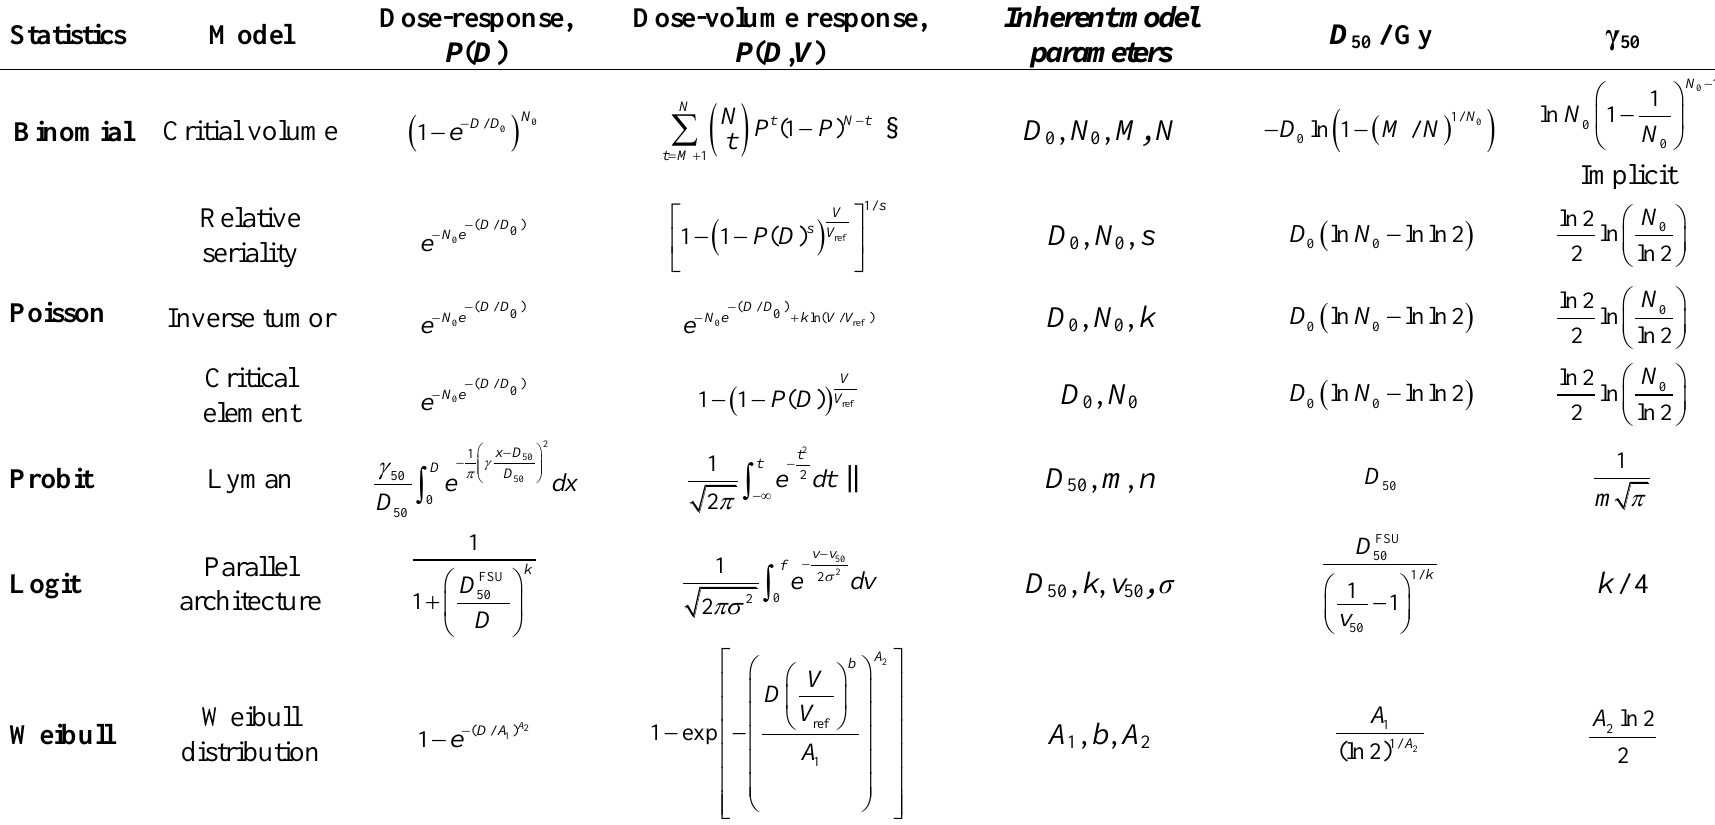
Table 1. Overview of the examined dose-response models together with a summary of their inherent parameters.